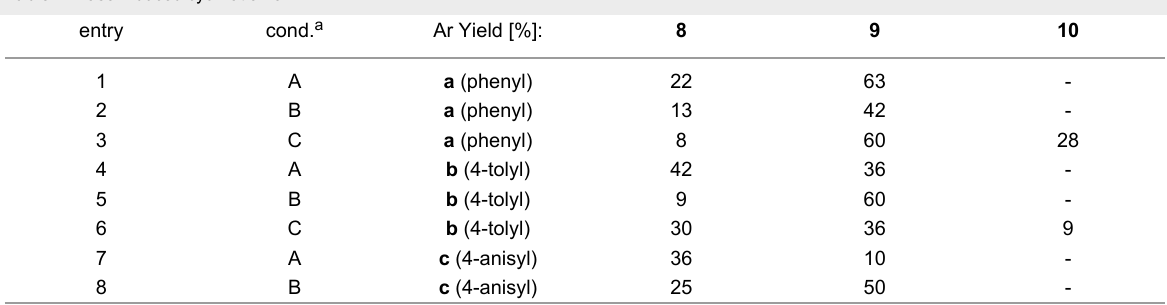
Table 1: Base-induced cyclization of 7 . entry